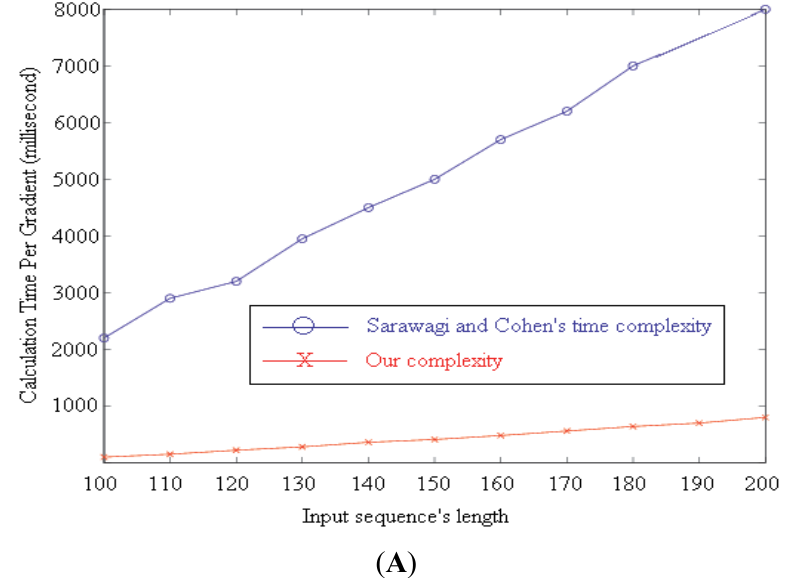
( B ) Comparison of recognition results; ( C ) Single day recognized